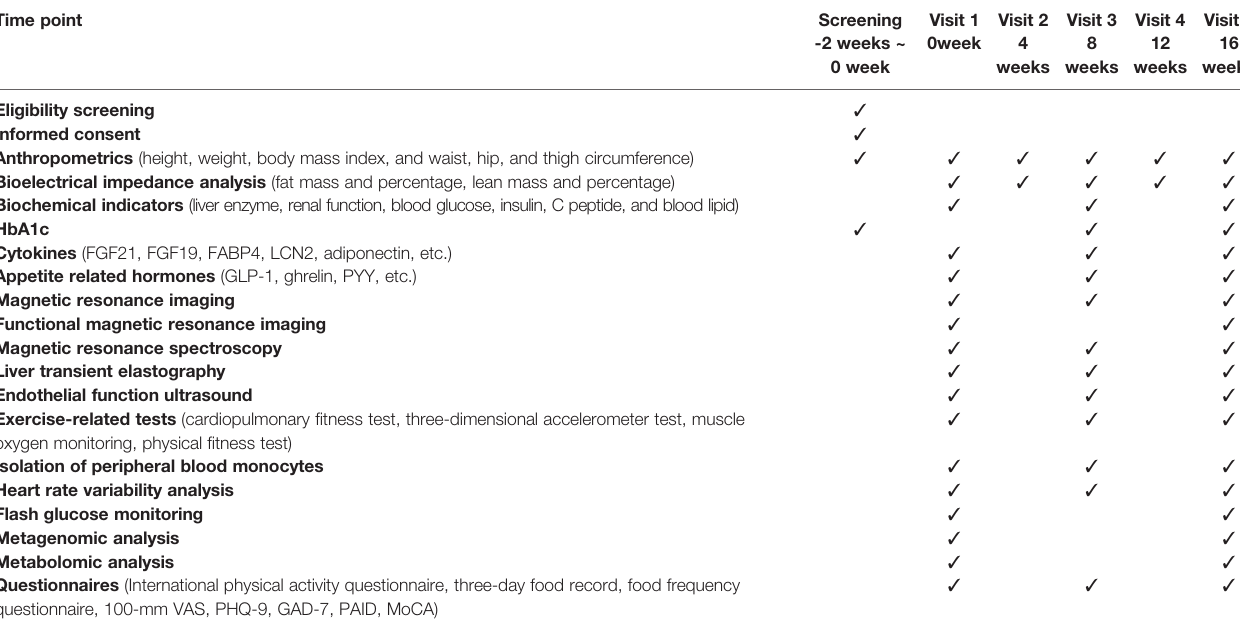
TABLE 2 | Schedule of the study